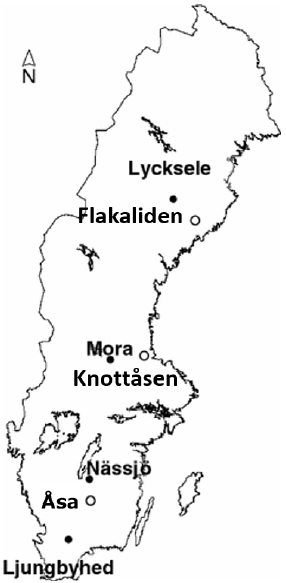
Figure 2. Location of the four study sites in Sweden modified from Svensson et al. (2008a). Filled cycles represent the four studied sites. Open circles are the measured sites reported in Lindroth et al. (2008) used for